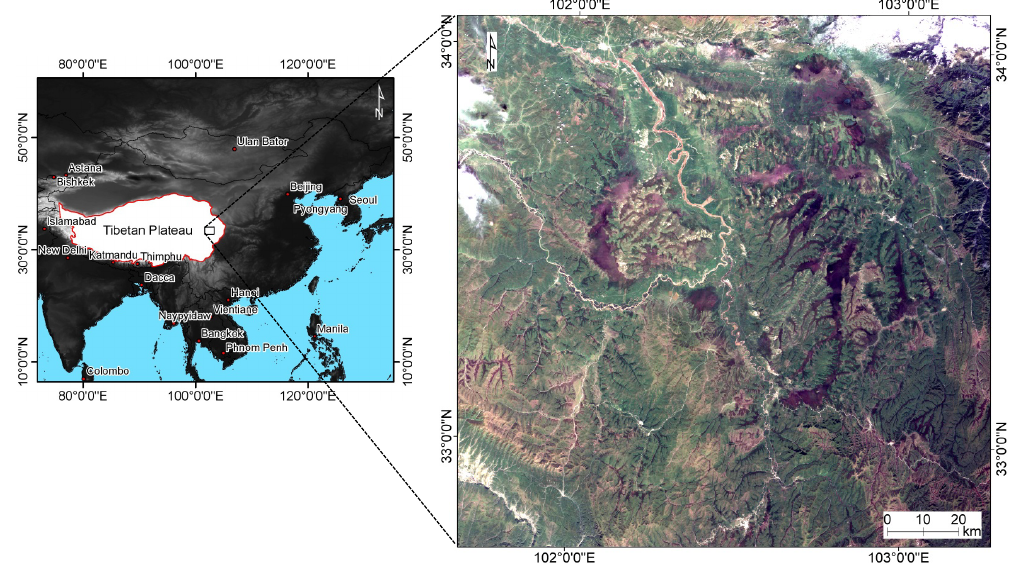
Figure 1. Location of the study area. The satellite image on the left is the subset of HJ1B CCD2 image acquired on 16 August 2010 shown with true color compositing (bands 3, 2, 1 in red, green and blue).